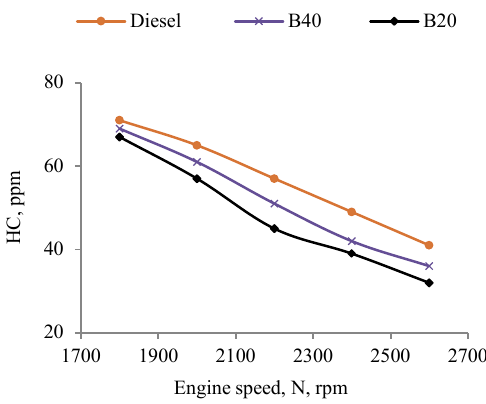
Fig. 12. HC emission in diesel engine for diesel and biodiesel blends.